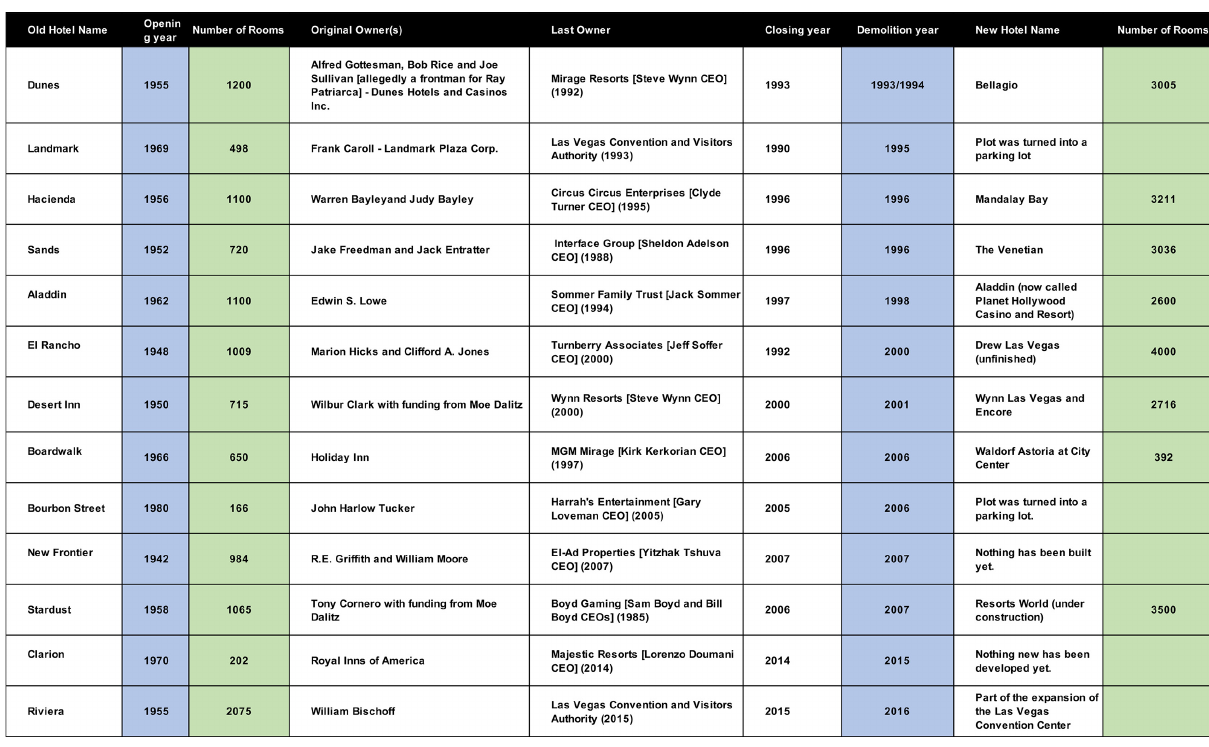
Figure 2. Fits‐and‐starts type of urban change occurs in a concentrated period of time : Table of 13 casinos, hotels, and resorts—and their hybrid complexes—demolished between 1993 and 2016 and replaced by new ones along the Las Vegas Strip. In terms of fits‐and‐starts type of change, it is interesting to note two phenomena in particular in this table: The rel‐ atively short time between the opening of the casino‐hotel‐casino and its demolition (e.g., only 35 years passed between the opening of the Dune in 1955 and its demolition in 1993) and the often vast differences in the original number of rooms and the number of hotel rooms in the new casino‐hotel‐resort (e.g., the original Sands had 720 rooms and its replacement the Venetian has 3,036 rooms—a more than four‐fold increase). Note: In thoroughly conducting this research we found that a lot of existing scholarship about Las Vegas often repeats inaccurate facts and even indulges in popular myth‐building. Therefore, to craft this table, we consulted 46 different reliable sources to check and cross‐check these facts (for the full table and its many sources see Supplementary Material). Source: Courtesy of Juan Usubillaga, from multiple